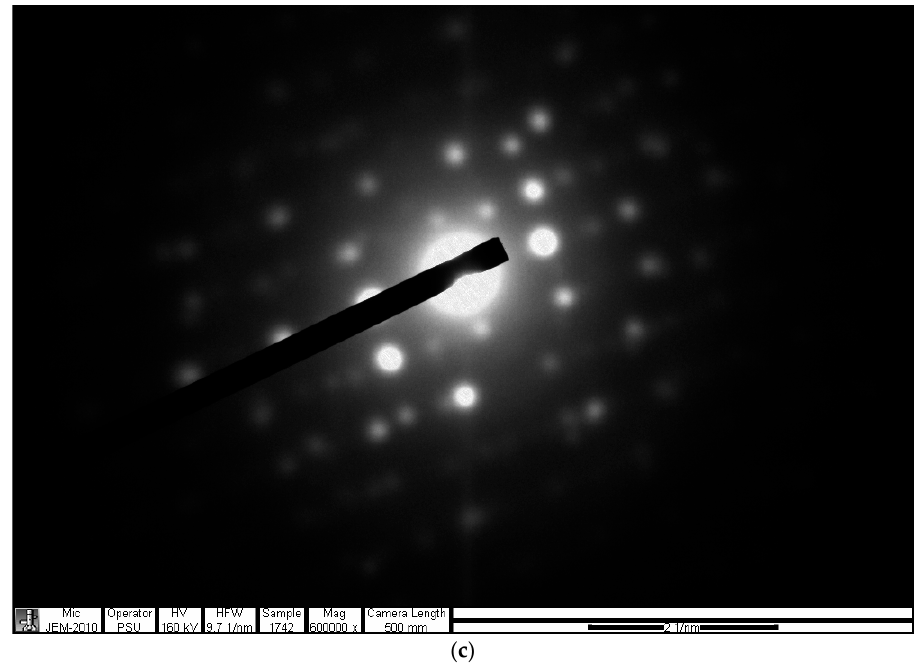
Figure 9. ( a ) TEM image for lattice space analysis. ( b ) TEM image of reduced graphene oxide nanomaterials. ( c ) Selected Area Electron Diffraction (SAED)